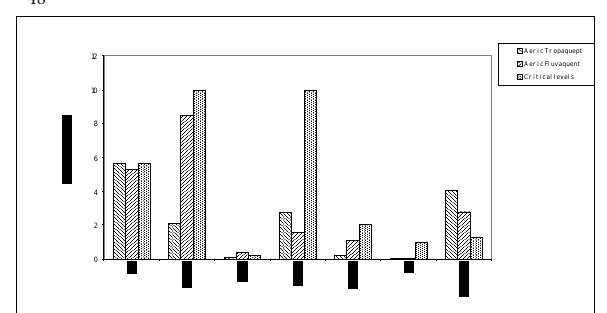
Fig 1. Important soil chemical properties of iron toxic Fig. 1.Important soil chemical properties of iron toxic soils